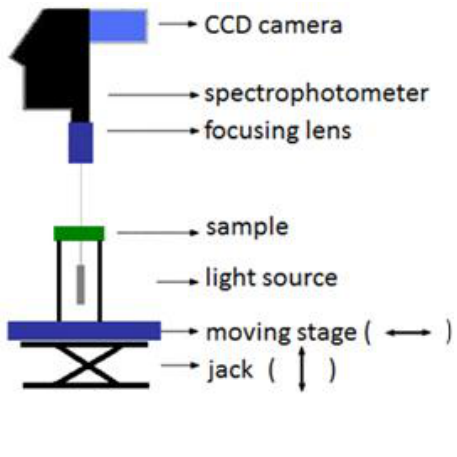
Figure 1. The lab-based hyperspectral imaging system in transmission